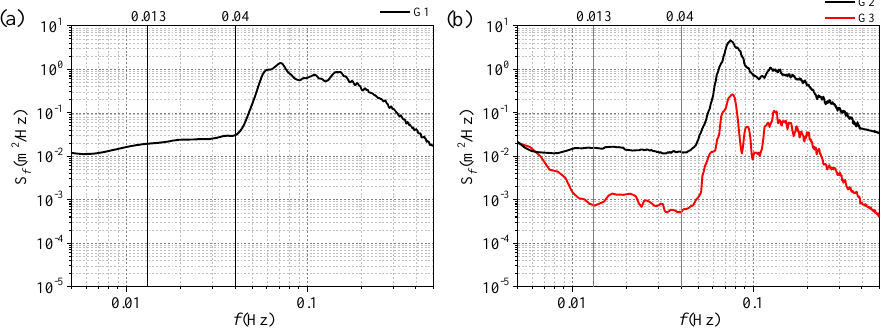
Figure 3. Day-averaged spectra at the location of three sensors: ( a ) sensor G1 and ( b ) sensor G2 (black) and sensor G3 (red).